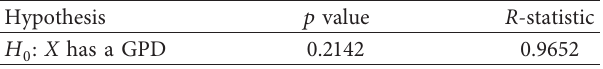
Table 4: Goodness of fit of GPD to the exceedances.